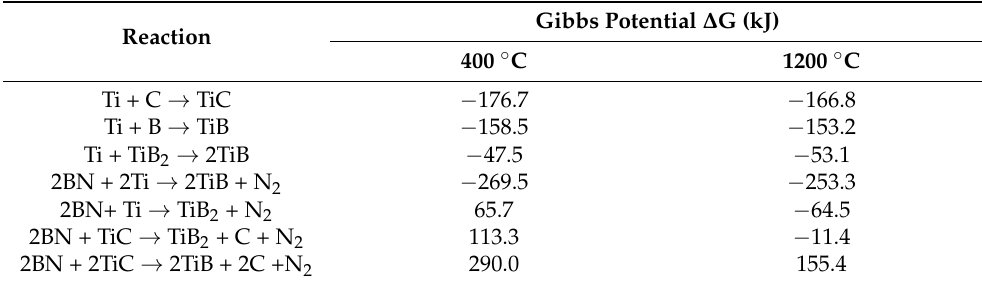
Table 2. Gibbs free energy for selected reactions in Ti–C–B–N system at temperatures of 400 and 1200 ◦